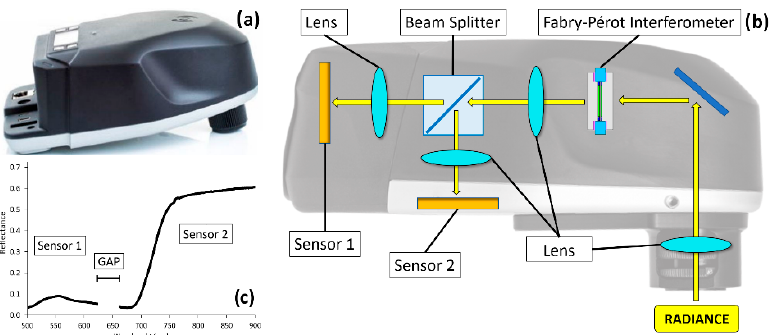
Figure 7. Senop Hyperspectral sensor HSC-2 ( a ) with details of the optic system based on Fabry-Pérot Interferometer (FPI) technology, a beam splitter and two CMOS sensors ( b ). The graph ( c ) shows a reflectance vegetation signature composed by the two sensors, and the “gap-area” placed between them (@ 636 nm) with invalid data.